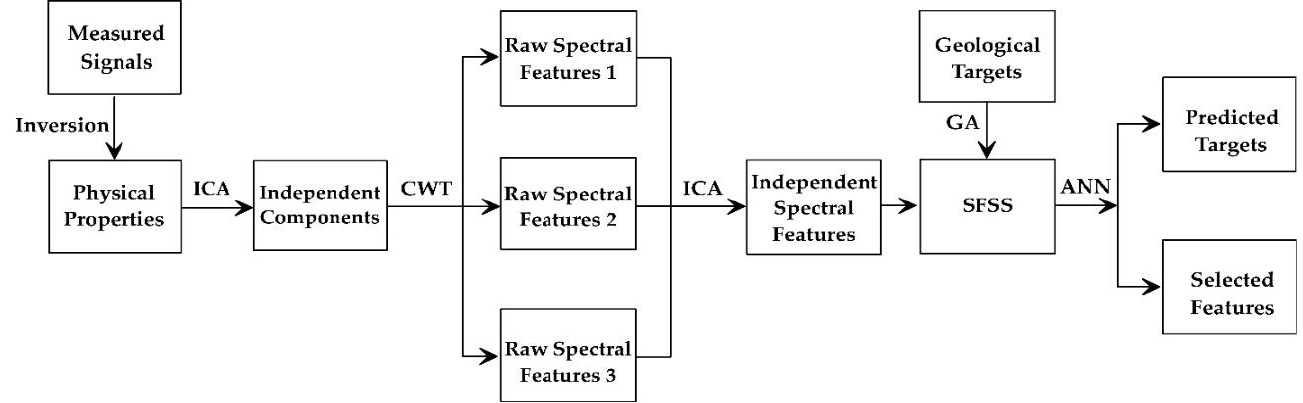
Figure 1. Workflow of SFSS for 3D predictive modeling.